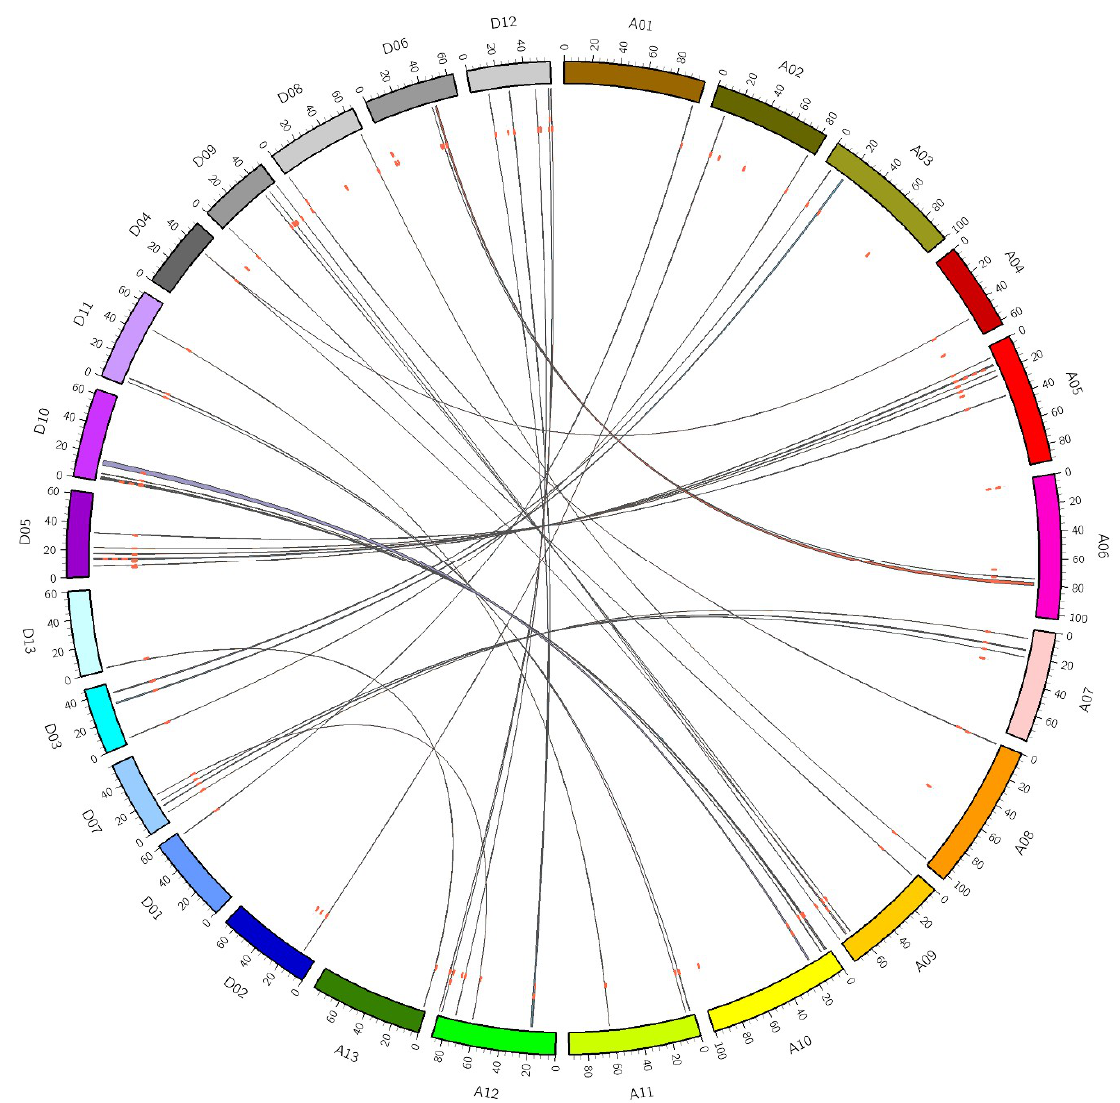
Figure 3. Synteny analysis of GhDof genes in G. Hirsutum L. The chromosomes of G. hirsutum L. are described in different colors in circle form. The red dots represent the distribution of each GhDof gene and the colored curves indicate the syntenic regions around the GhDof genes in G. hirsutum L. genomes.